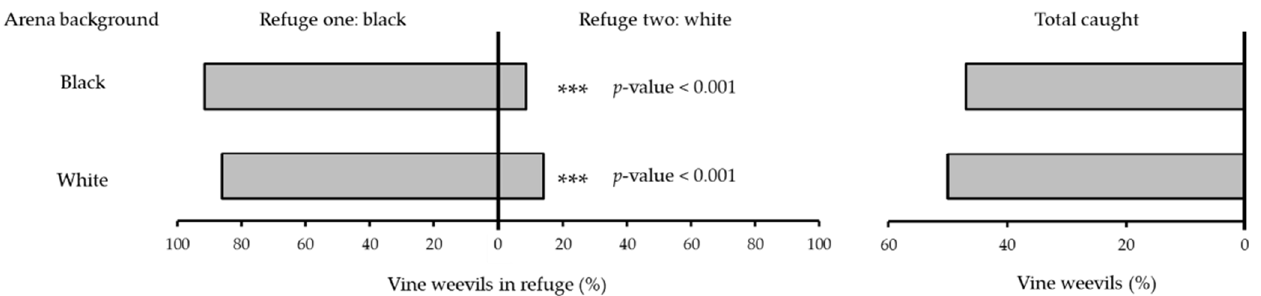
Figure 2. Percentage of vine weevil adults recorded in refuges painted black or white when released individually ( number of replicate days = 10) into a cage with a black background or white background. Asterisks indicates significant differences between refuge choices.